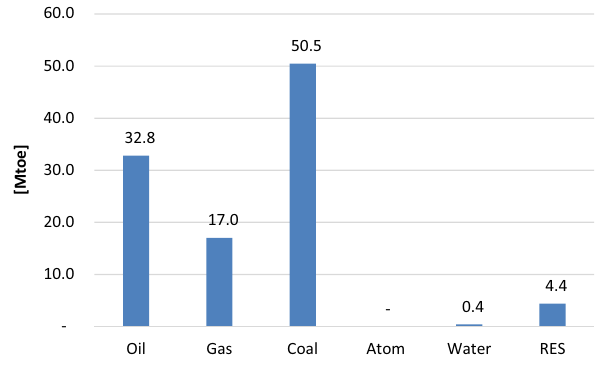
Figure 9: Primary energy consumption in Poland in 2018. Source: own work based on ref. [ 2 ]